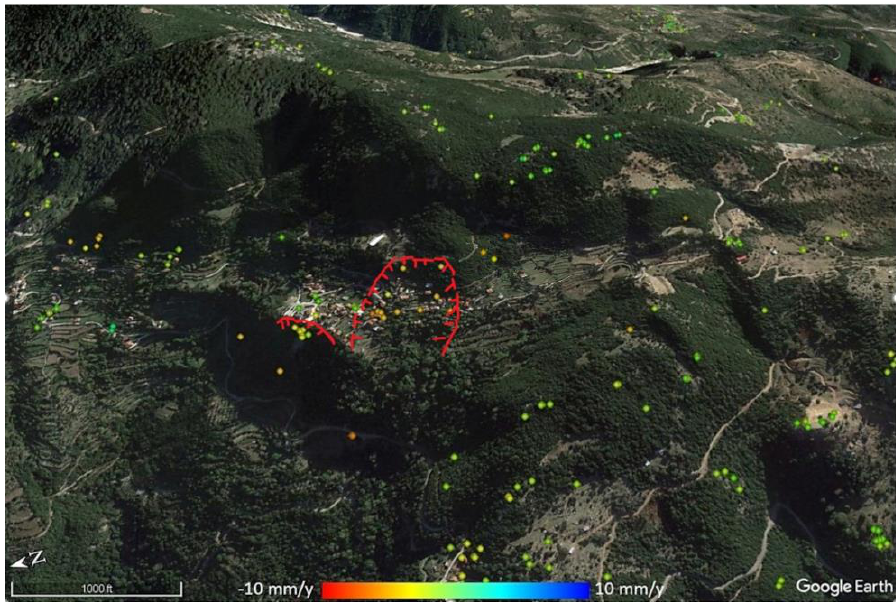
Figure 9. Failures affecting Peristeri village. The central part of the village is affected by a rotational slide moving with LOS velocities ranging from 3 to 6 mm/y and the northwestern side, along the crest of the slope, appears to be affected by a small debris flow expanding with LOS velocities of 2 to 3 mm/y.